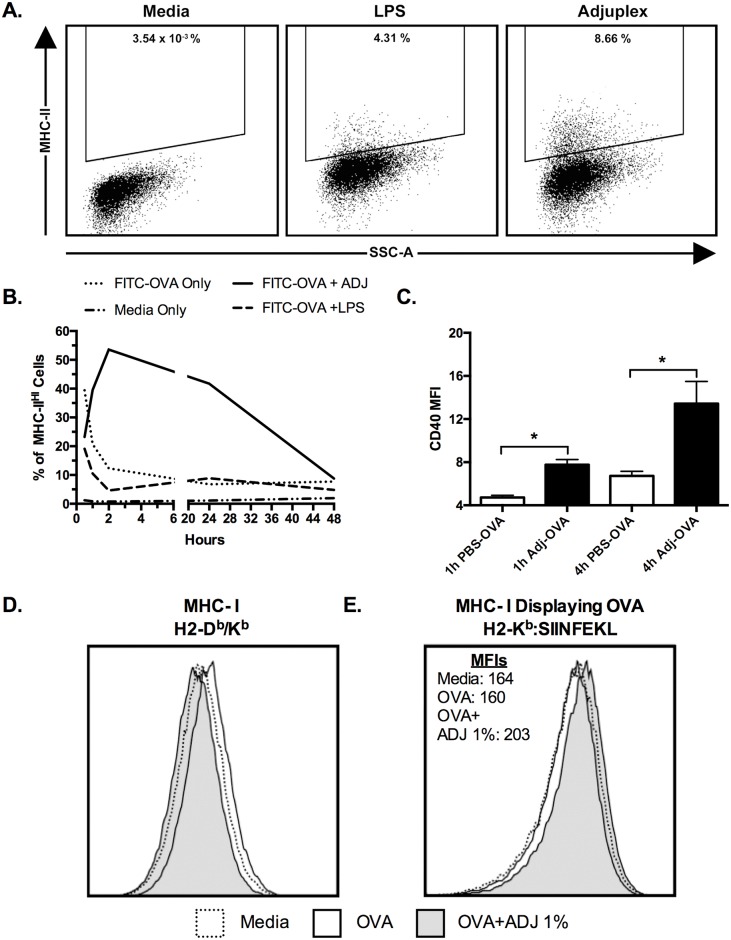
Adjuplex Alters Antigen Presentation and Activation of DC2.4 cells.(A-B) DC2.4 cells were cultured with 200 ug/ml FITC-OVA alone or supplemented with 1% ADJ or 5 μg /ml LPS. After 30 minutes, the treatment media was aspirated, washed, and maintained in growth media. The cells were harvested at 0.5, 1, 1.5, 2, 24 and hours and processed for flow cytometry. Panel A shows the gating strategy for MHCIIHI DC2.4 cells. Graph in (B) shows the kinetics of MHC-II expression on all DC2.4 cells as measured by the MFI of anti-I-Ab (MHC-II) antibodies. (C) DC2.4 cells were cultured in a 96-well plate in media containing 200 μg/ml FITC-OVA with or without 1% ADJ for 1 or 4 hours. Magnitude of DC2.4 cell activation as measured by the MFI of CD40 on all DC2.4 cells. (D) MHC-I expression on DC2.4 cells 24h after pulse, as characterized by fluorescent labeling of MHC-I with anti-H2-Db/Kb antibodies. (E) Expression of the MHC-I allele H2-Kb bearing SIINFEKL peptide (H2-Kb:SIINFEKL) at 24h after pulse, as characterized by fluorescent labeling by antibodies specific for the Kb:SIINFEKL-complex). Error bars = SEM, * = p<0.05. Data are representative of at least two independent experiments.